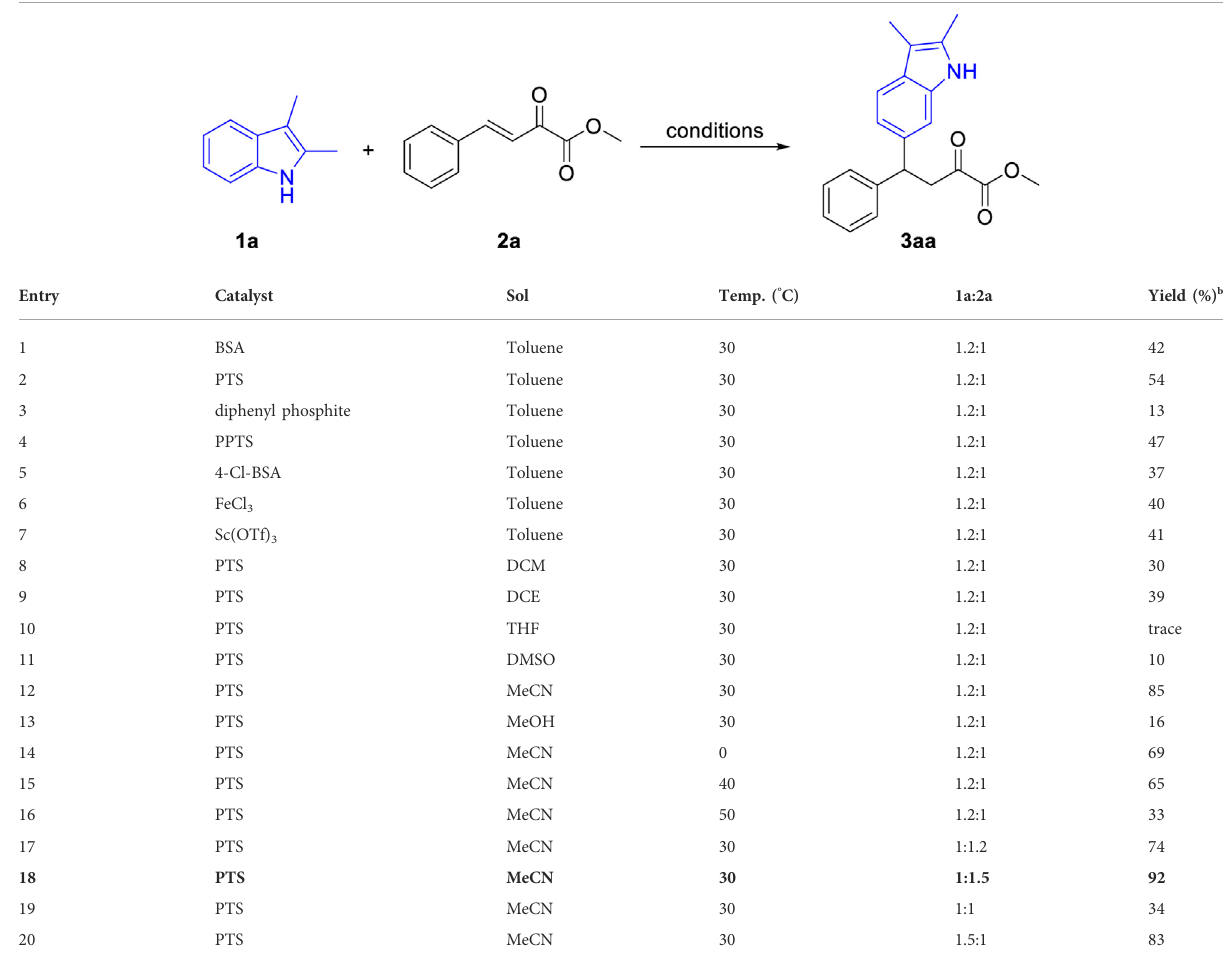
TABLE 1 Optimization of the reaction conditions a